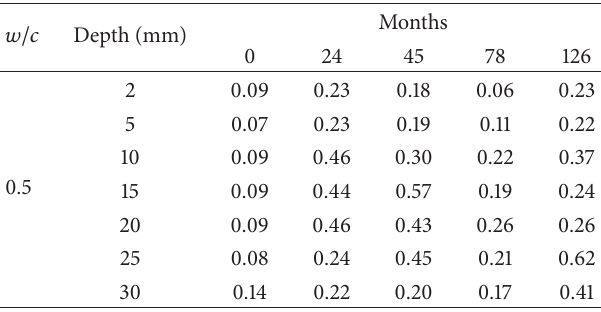
Table 1: Chloride concentration as a percent (%) of concrete weight during the study period.